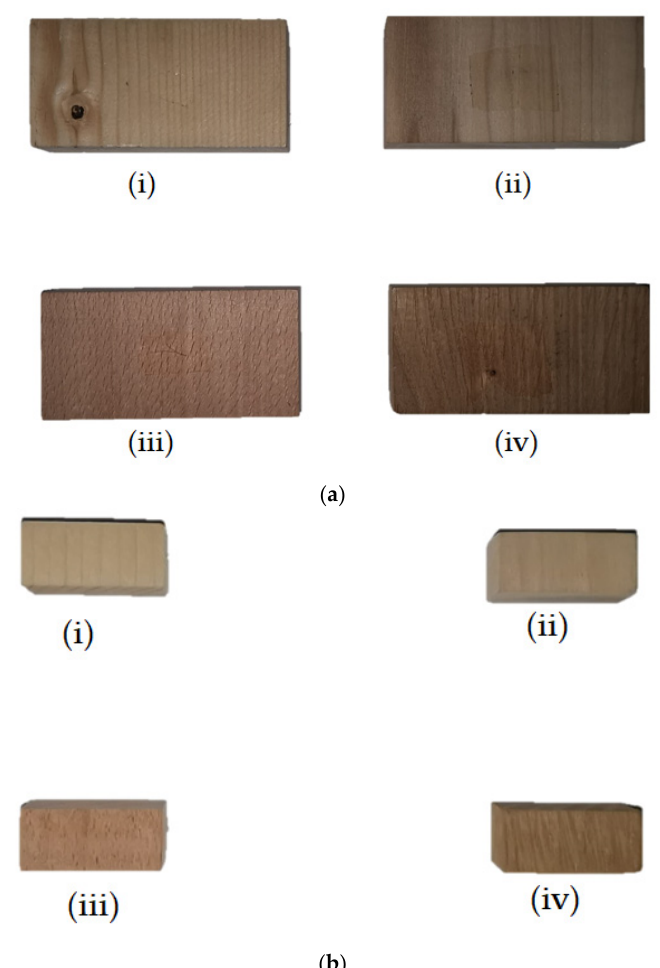
Figure 2. ( a ) Samples for WR-430 and ( b ) samples for WR-90. In each figure, (i) fir, (ii) poplar, (iii) beech, and (iv) oak